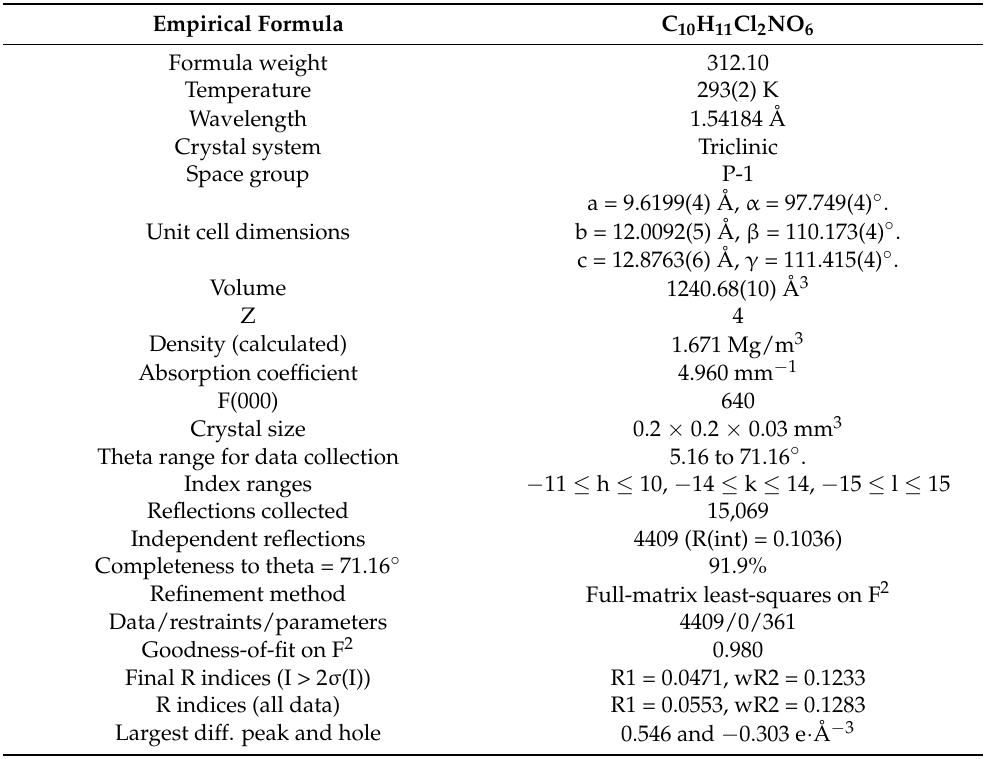
Table 1. Crystal data and structure refinement for N,N-dimethylglycine–chloranilic acid